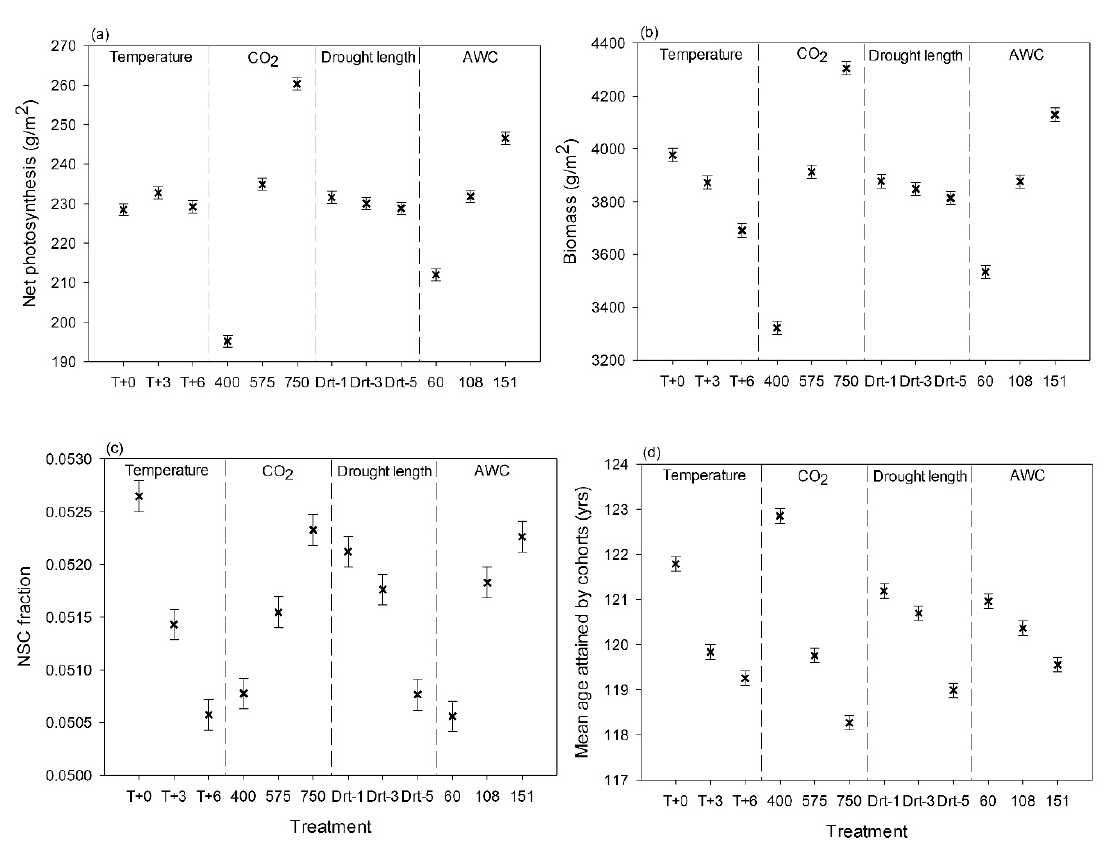
Figure 2. Mean and 99% confidence intervals (error bars) of ( a ) average annual net photosynthesis (R 2 = 0.015), ( b ) woody biomass ( r 2 = 0.014), ( c ) cohort energy reserves ( r 2 = 0.003) and ( d ) competitive exclusion ( r 2 = 0.008) of cohorts over 100 simulated years in response to the treatment levels, adjusted using least squares techniques. There was no evidence of important interactions except perhaps between temperature and AWC (Available Water Capacity) and drought and AWC in ( d ).